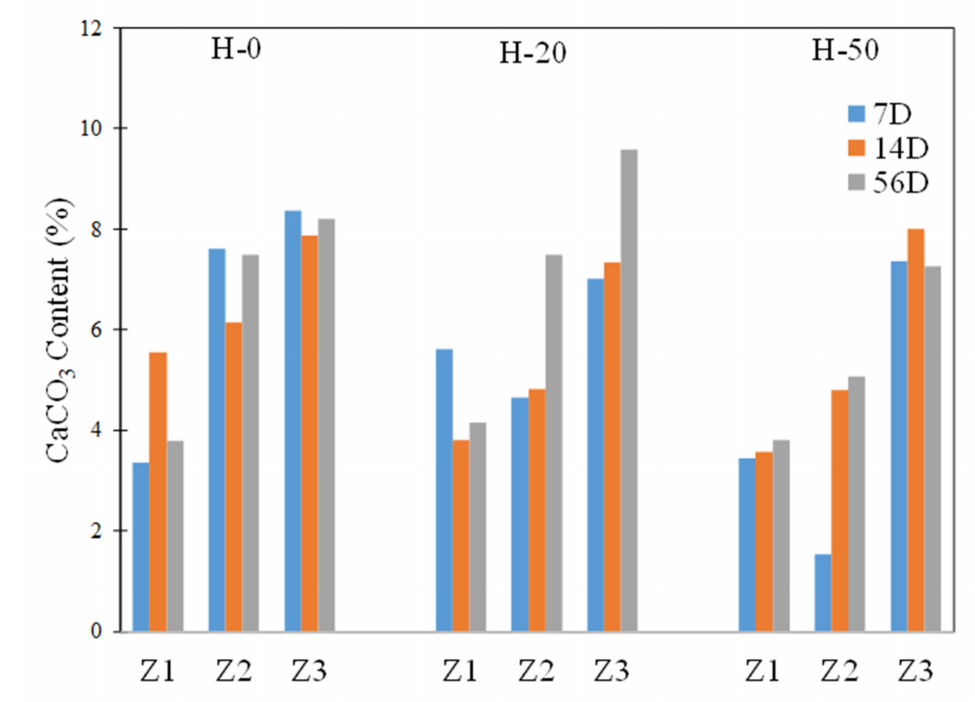
Figure 9. CaCO 3 content in zones, Z1, Z2, and Z3, surrounding the hydrogels.